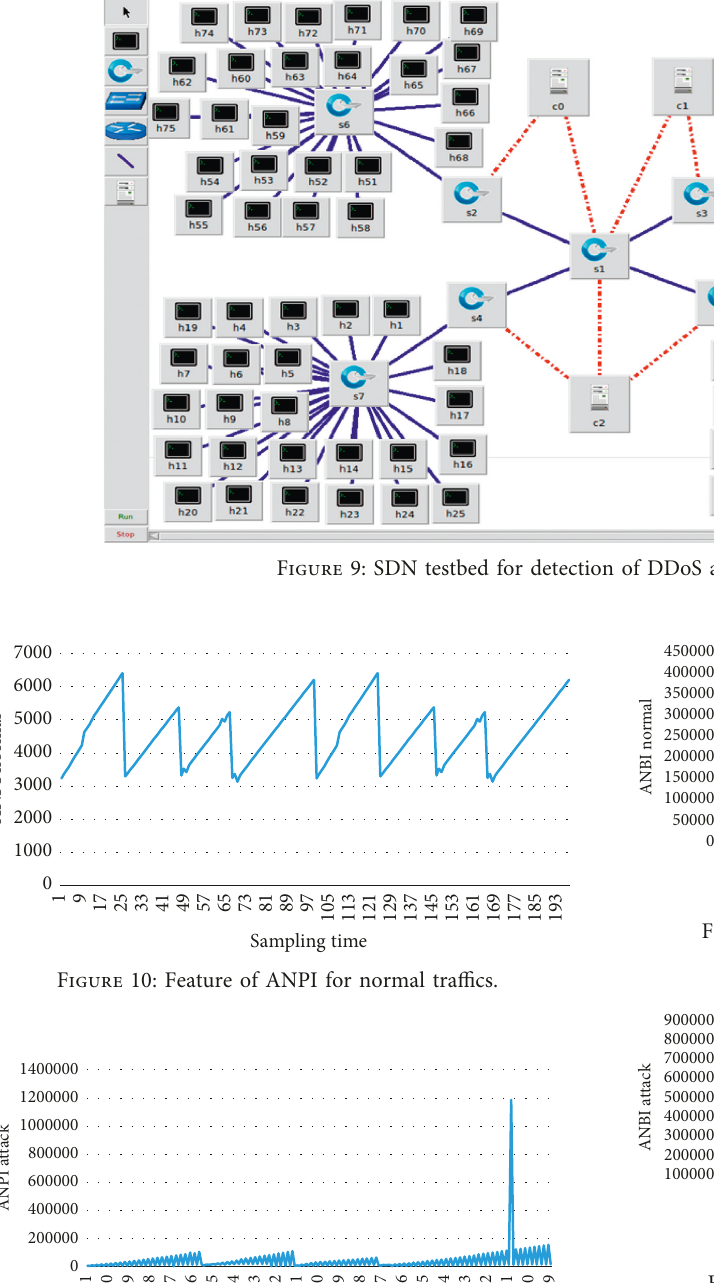
Figure 13: Feature of ANBI for attack